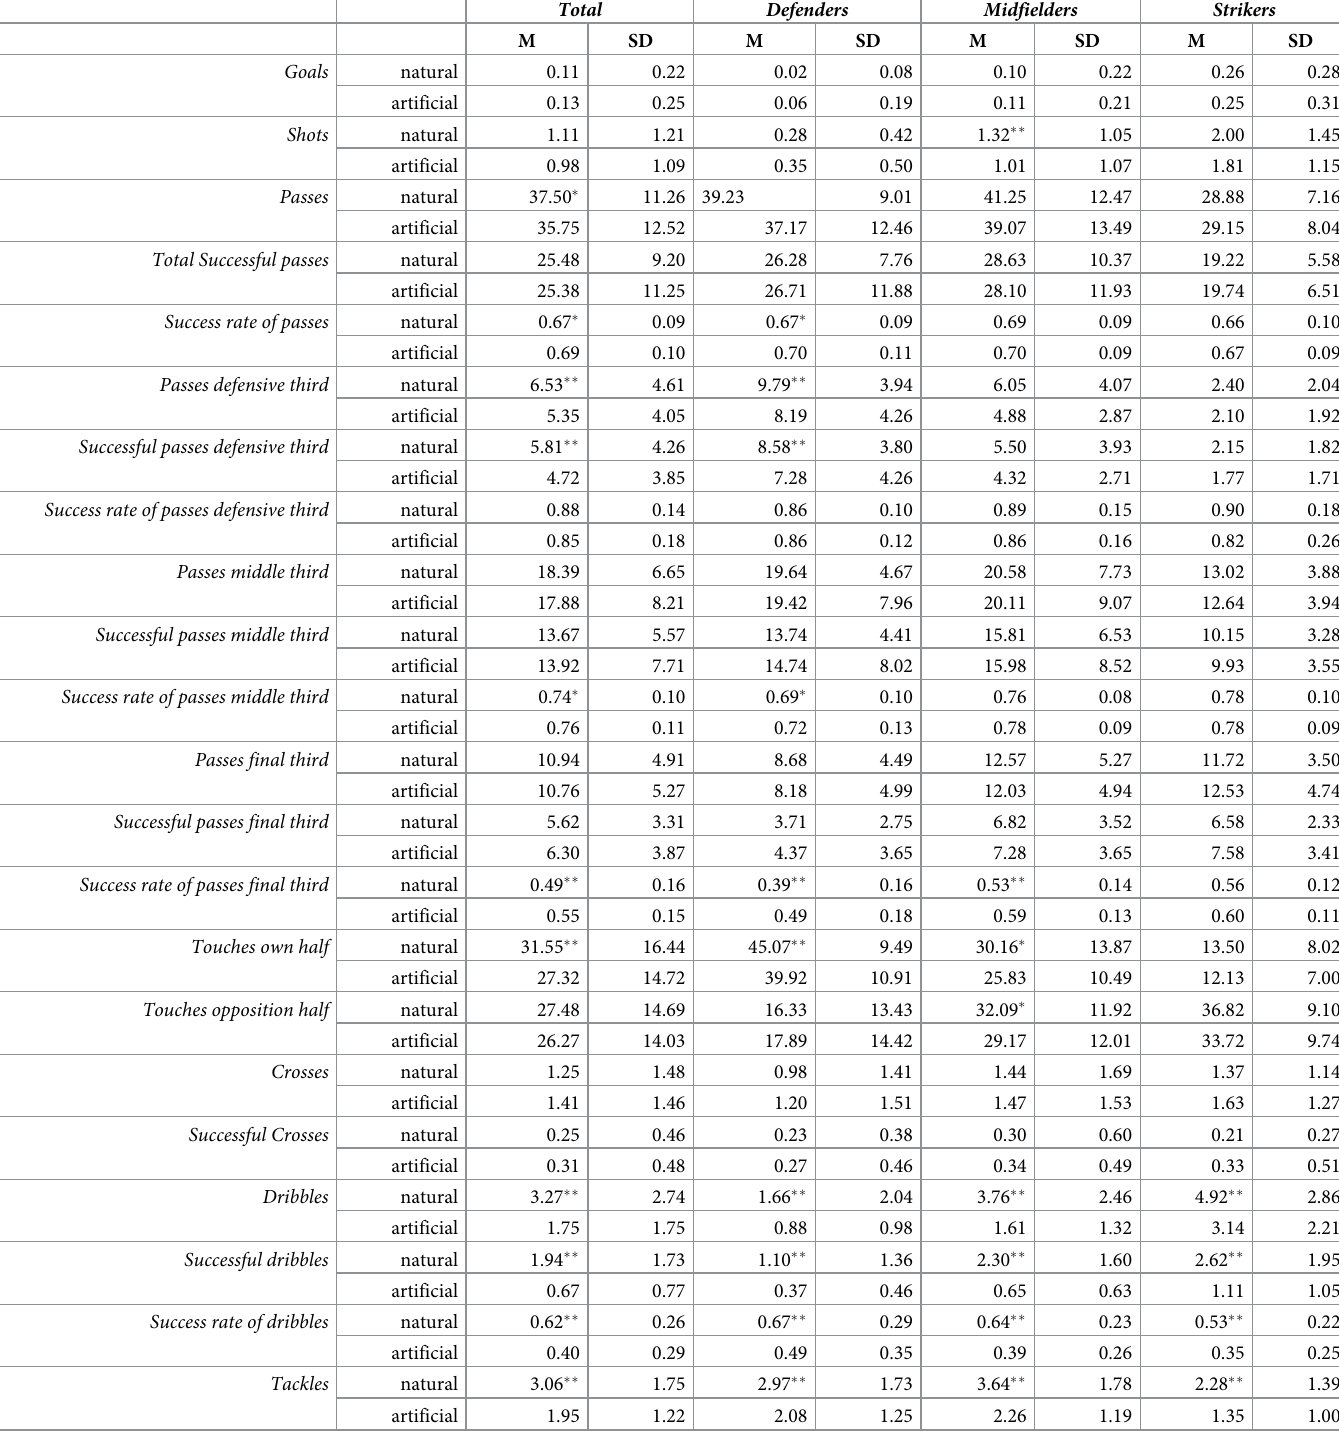
Table 2. Results of the variables analysed at the FIFA (Fe´de´ration Internationale de Football Association) Women’s World Cup 2011 (natural turf) and 2015 (artifi- cial turf).